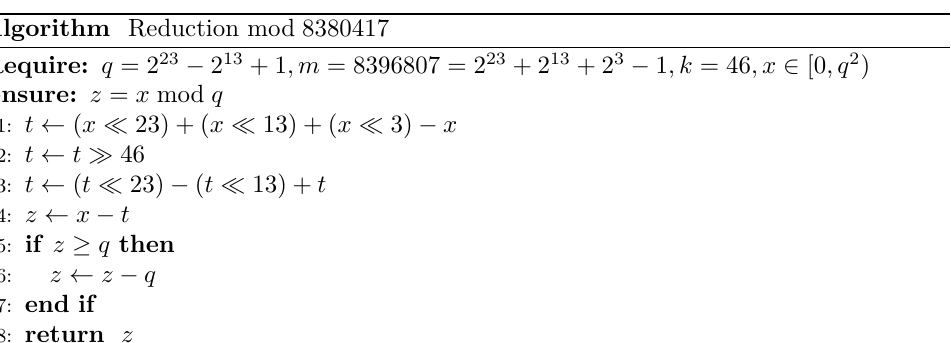
Algorithm Reduction mod